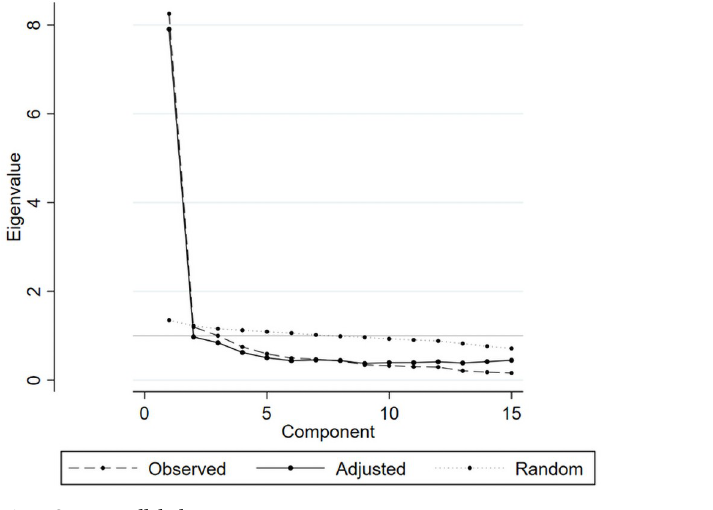
Fig 1. Scree parallel plot.